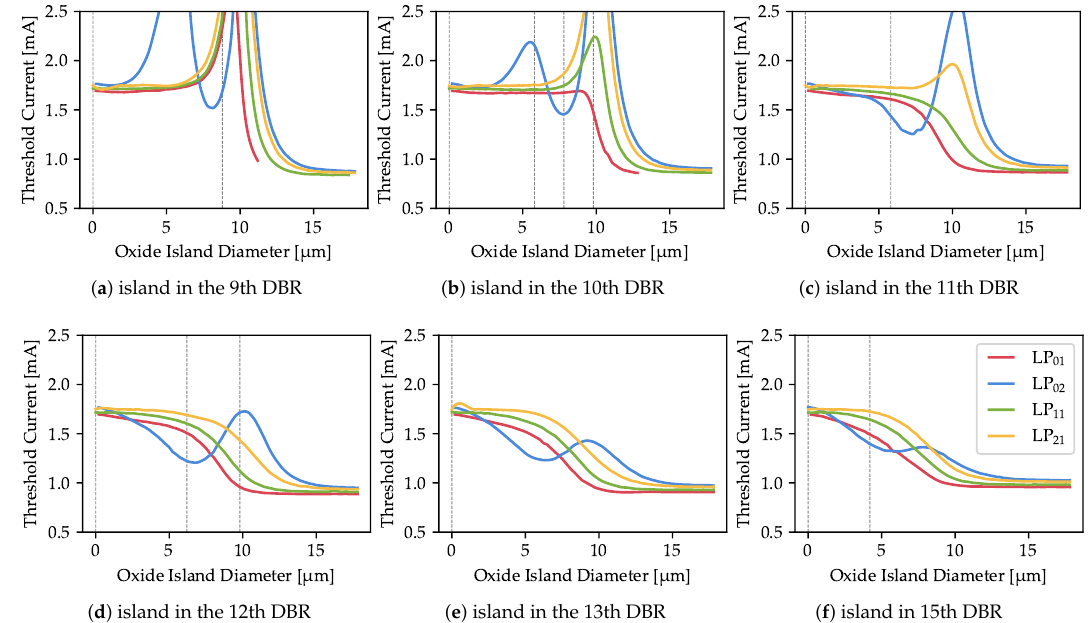
Figure 6. Dependence of threshold current on the size of the oxide island for several locations in the DBR layers. The position of the island has a strong impact the qualitative behavior of the modes. Below the 12th pair, strong oscillations are visible. A rapid increase in threshold current can be observed for critical island diameters (10µm and around 5µm for the LP 02 mode). Dashed gray lines indicate selected parameters for which the optical profiles are